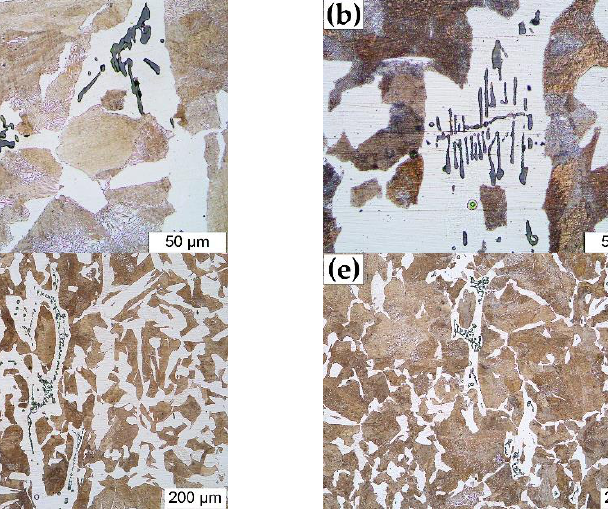
Figure 12. Effect of MnS inclusions on microstructure of the medium carbon structural steel 45#. ( a – c ) magnification × 500, ( d – f ) magnification × 100.